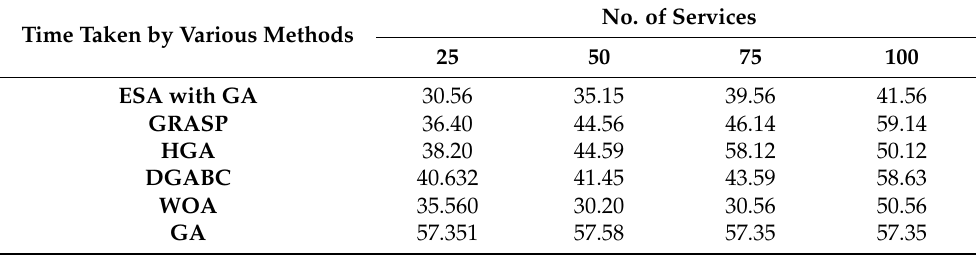
Table 5. Various stratagems’ execution times are evaluated (in